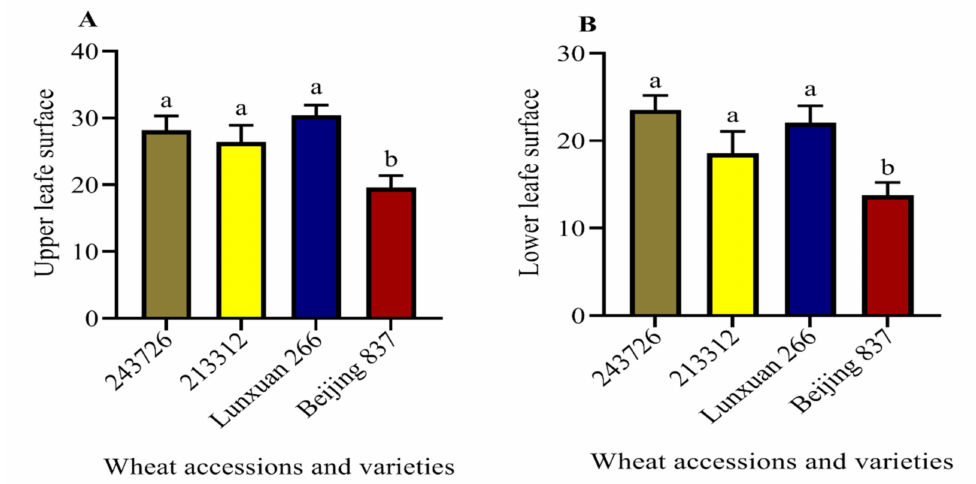
Figure 2. Trichome density of four wheat leaves. Bars represent the average number of trichome densi- ties per mm 2 (mean ± SE, n = 10). A and B indicate trichome density on the upper (adaxial) and lower (abaxial) leaf surfaces, respectively. Different letters above the bars indicate significant differences.